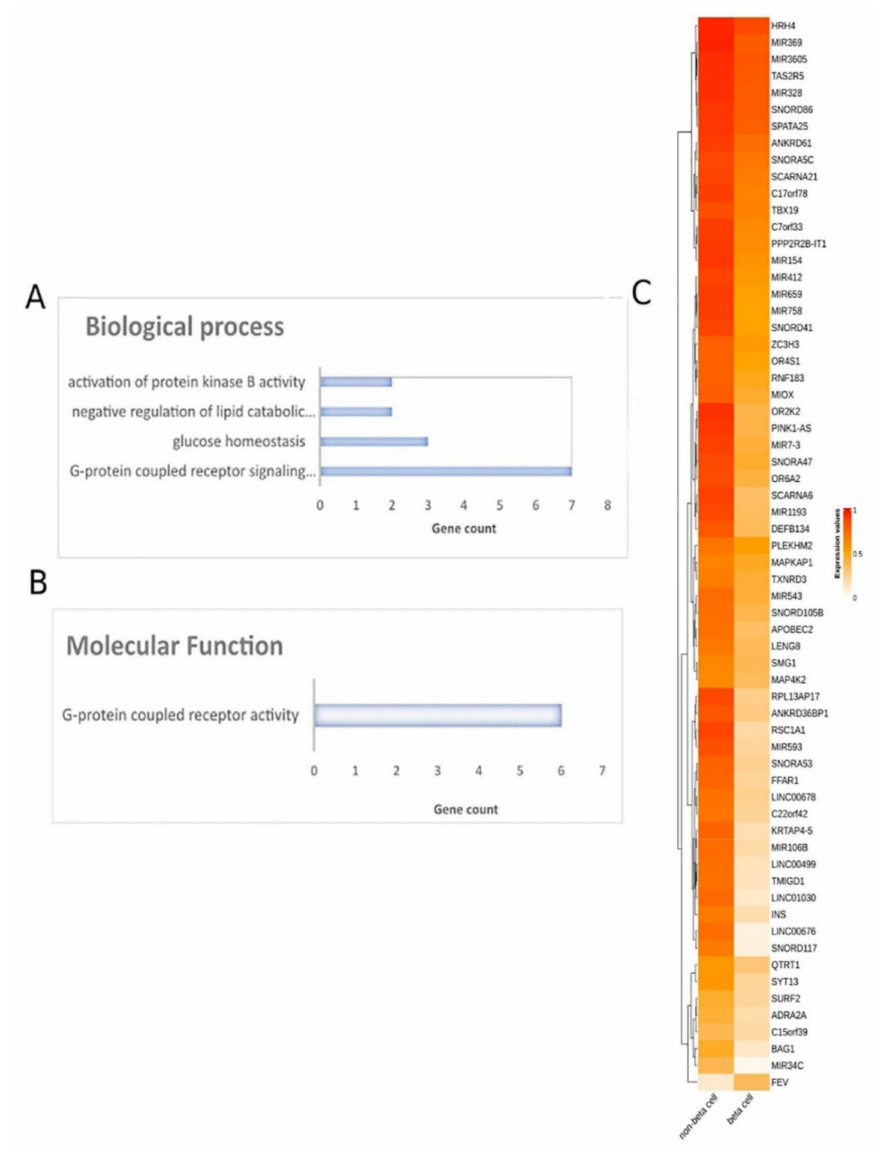
Figure 5. Differential methylation analysis comparing pancreatic β -cells and other tissues. Gene ontology analysis of 66 DMGs in the aspects of ( A ) biological process and ( B ) molecular function analysis. ( C ) Heatmap plot of 66 DMGs comparing pancreatic β -cells and other healthy tissues. Abbreviations: DMGs = differentially methylated